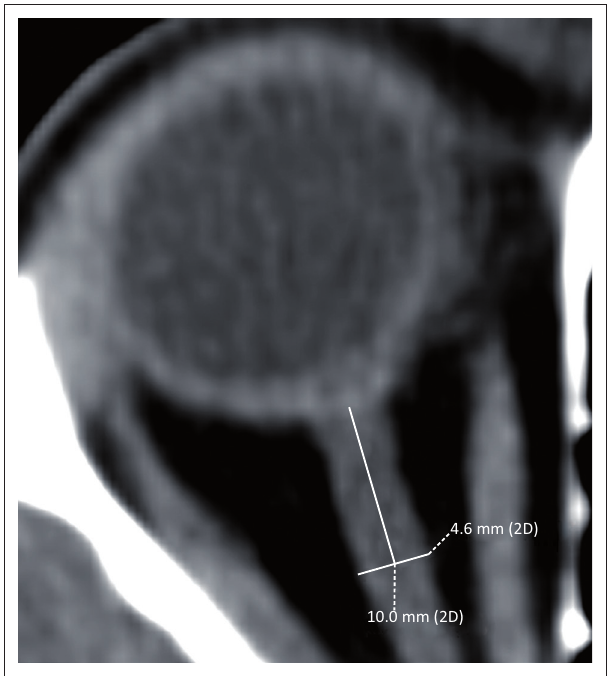
FIGURE 1: Optic nerve sheath diameter measurement on an axial computed tomography